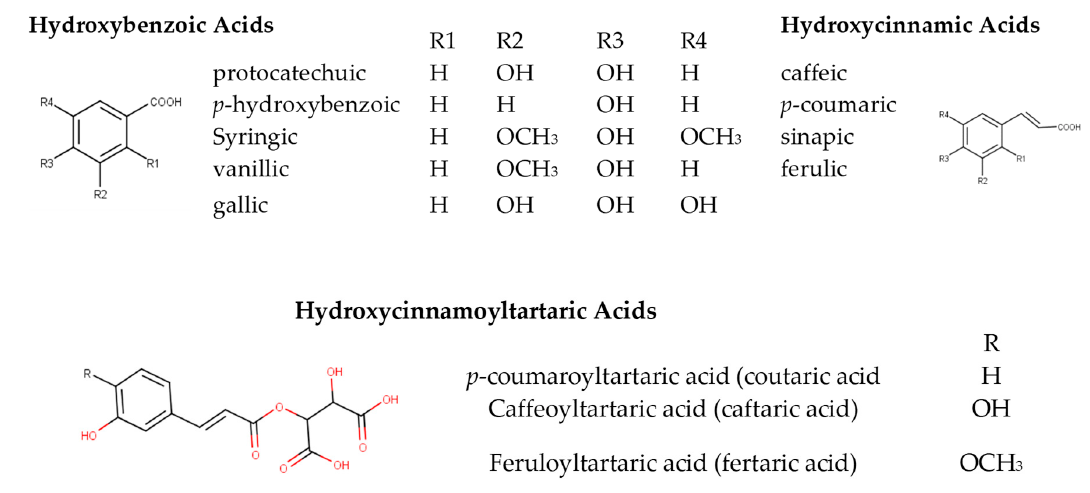
Figure 1. Basic structures of phenolic acids in wine.